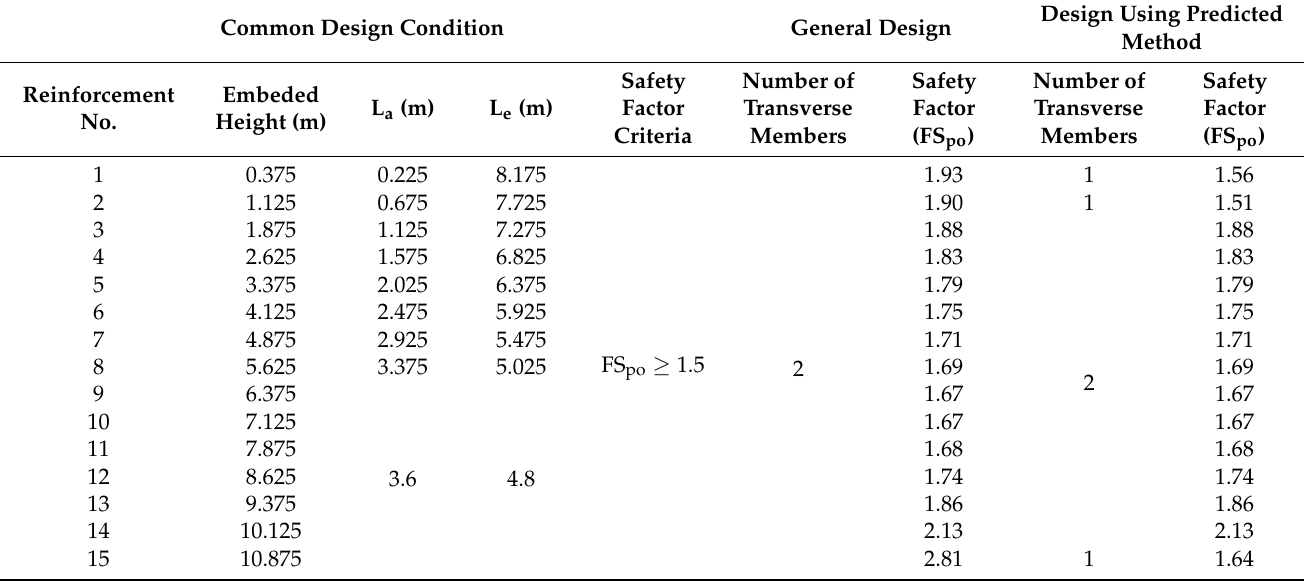
Table 4. Design results on pullout resistance according to predicted